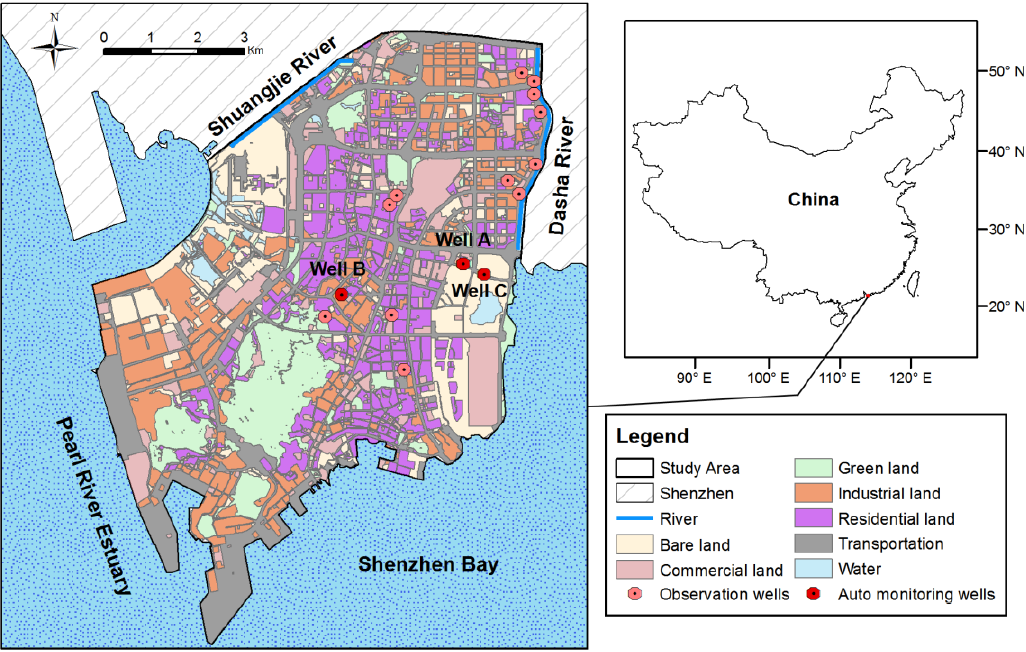
Figure 1. Study area and land use.